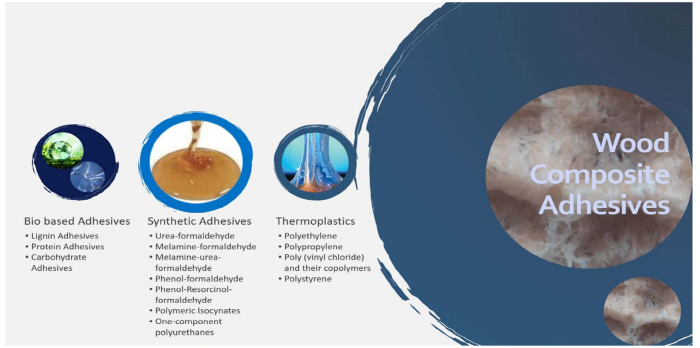
Figure 3. Adhesives for wood